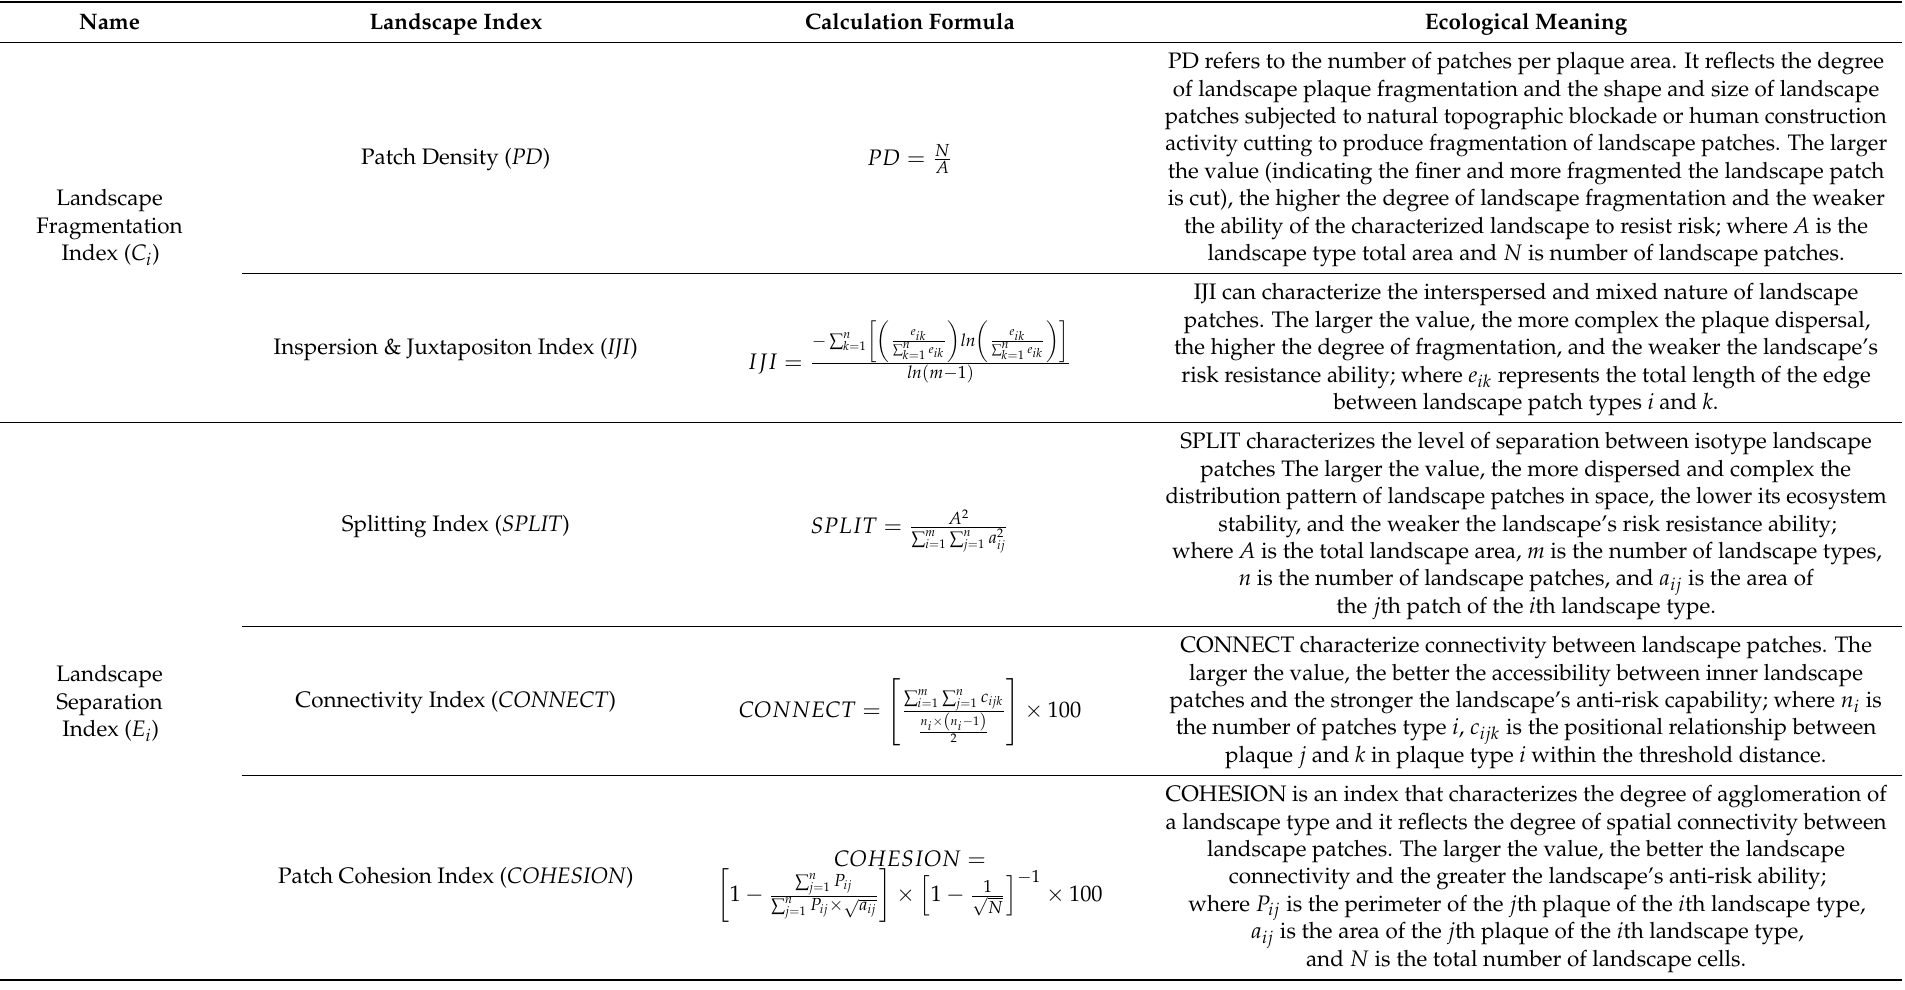
Table 3. Landscape Ecological Risk